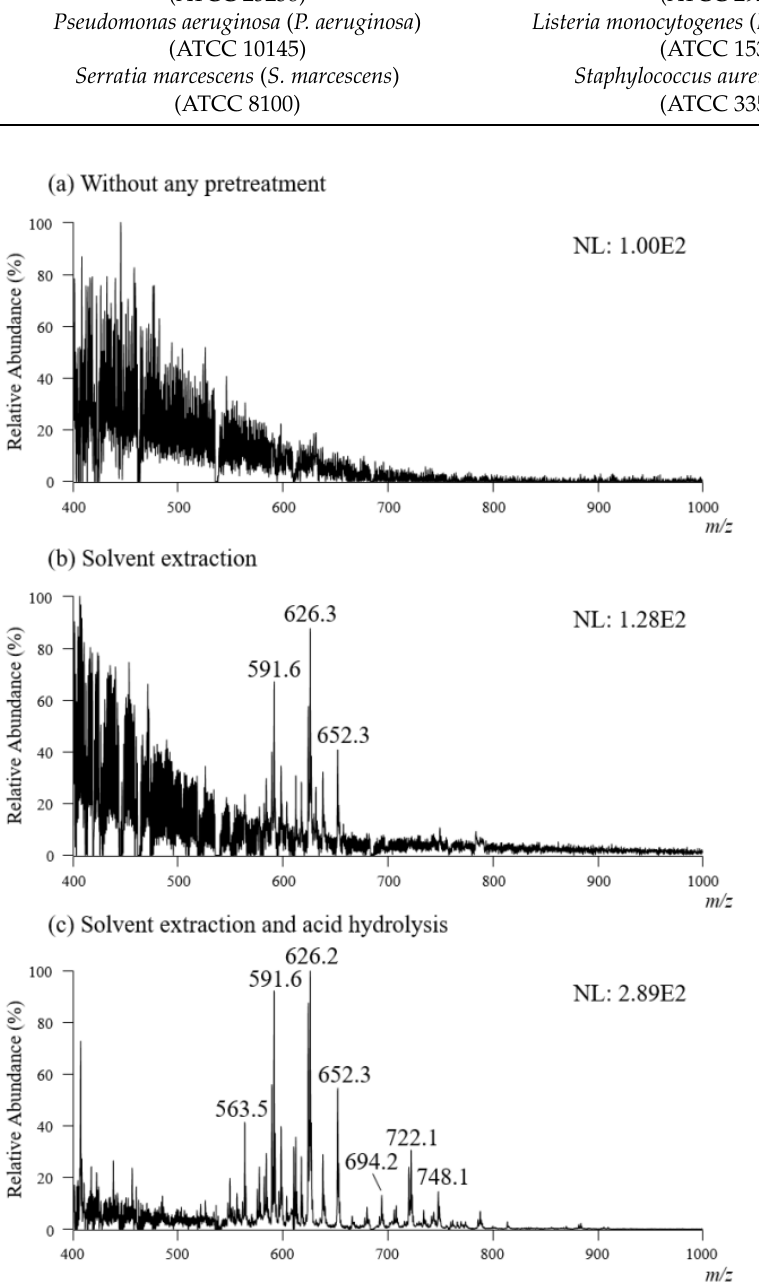
Figure 3. TD-ESI mass spectra recorded in the positive mode of E. faecalis : ( a ) without any pretreatment, ( b ) extracted with chloroform/methanol (2:1, v / v ) solution, and ( c ) treated with chloroform/methanol (2:1, v / v ) solution containing 5% TFA.